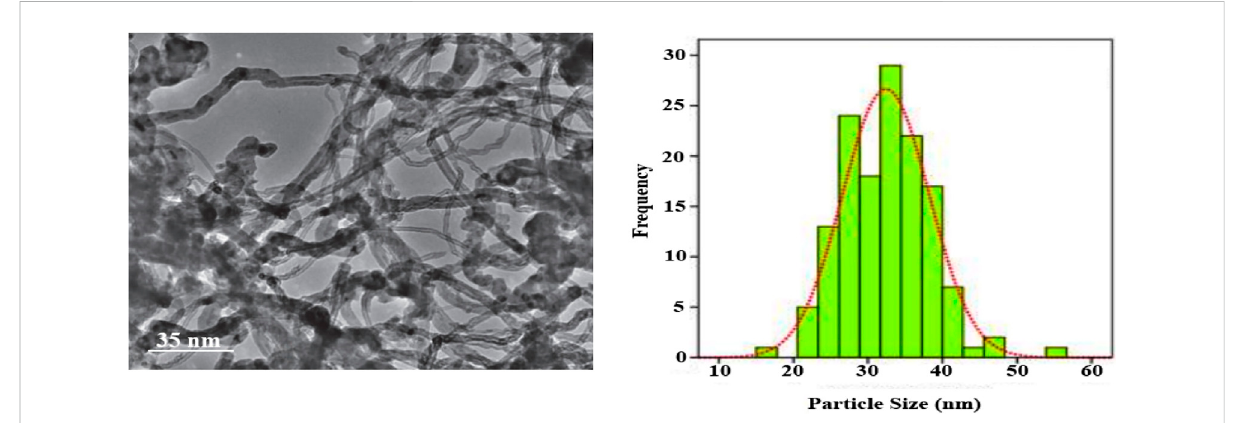
FIGURE 3 TEM image and histogram curve of Ag/Fe 3 O 4 /CdO@MWCNT MNCs.